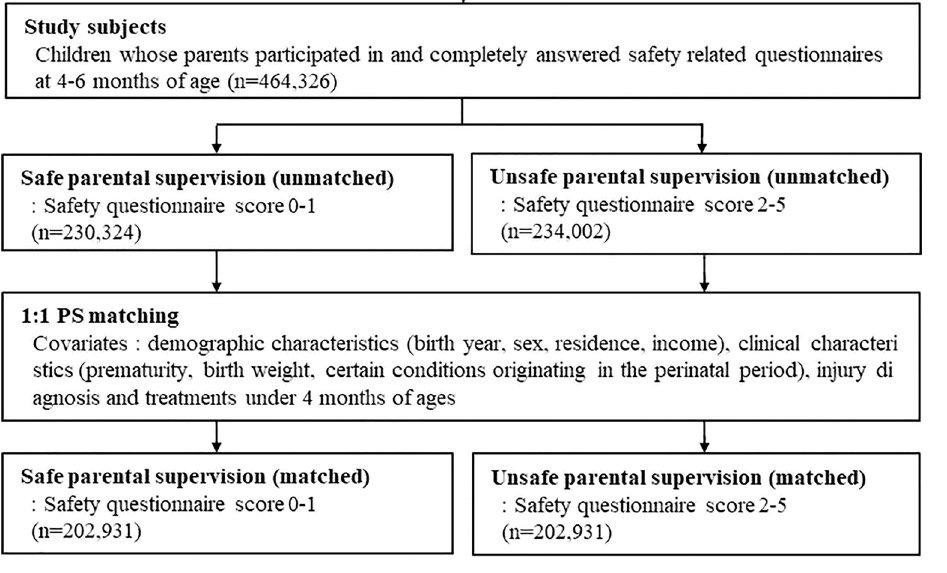
Figure 2. Disposition of participating